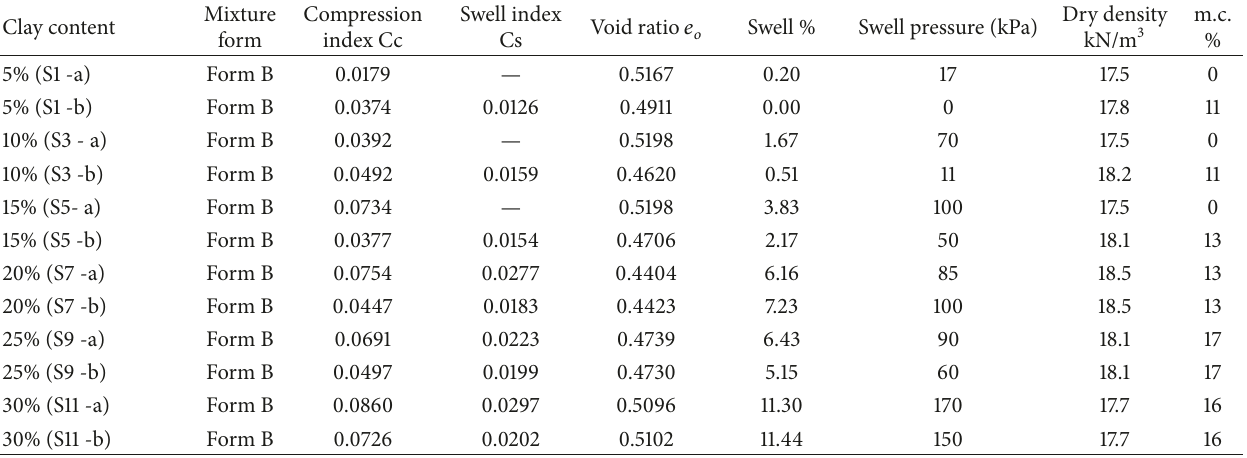
Table 6: Summary of swell and compression data for Form B clay.